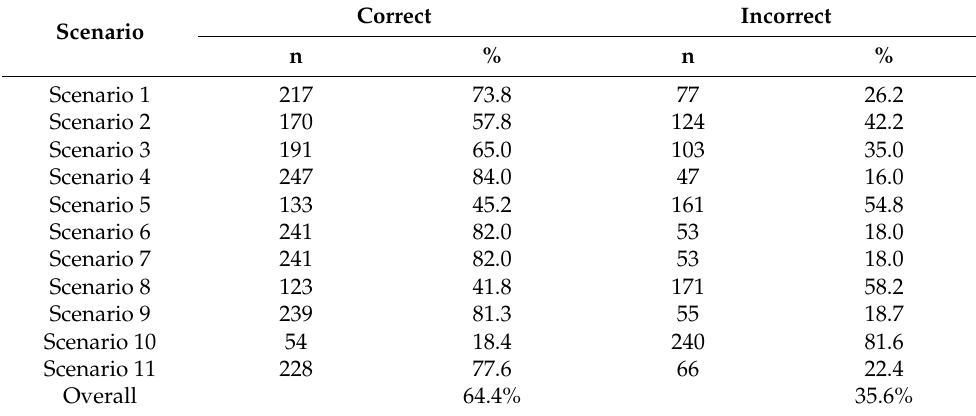
Table 4. Participants’ Understanding of the Speech-Language Pathologist’s Scope of Practice based on Scenarios (N = 294).